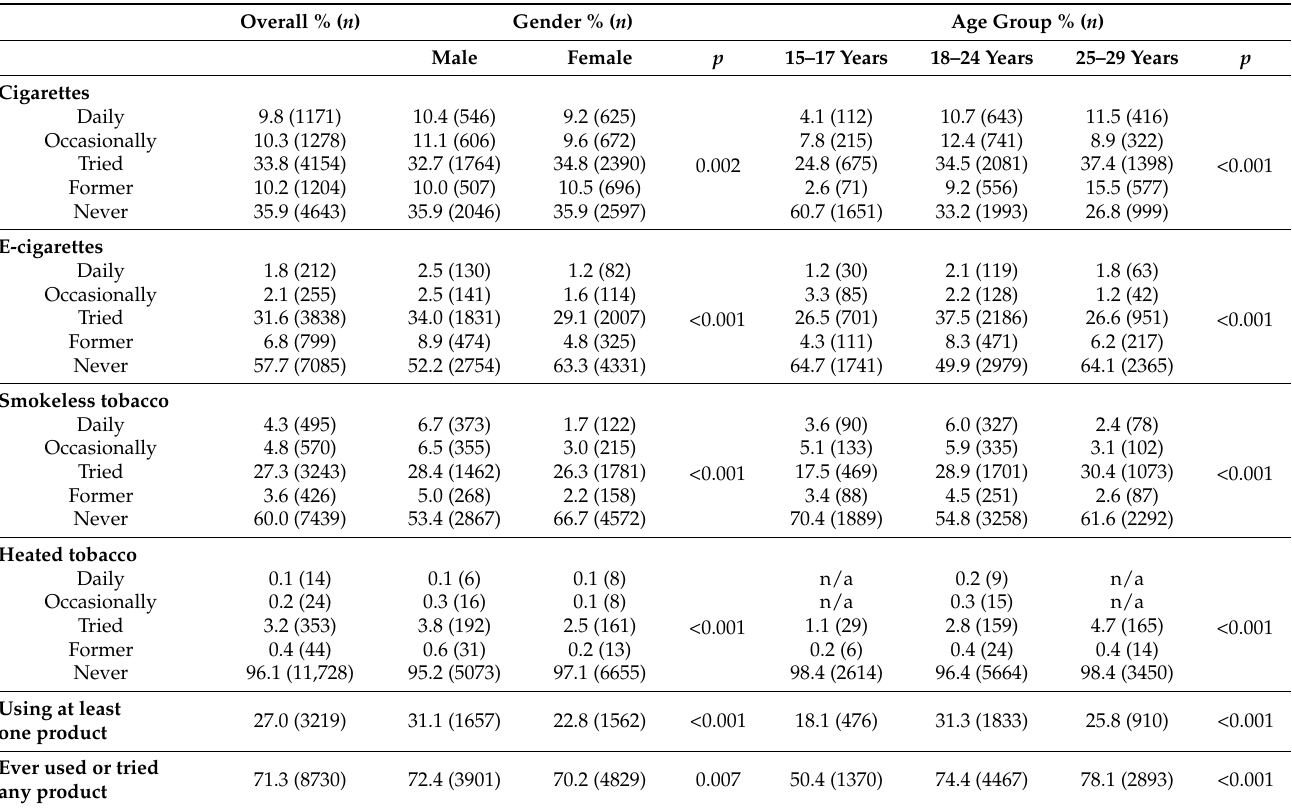
Table 3. Use of tobacco or nicotine products by gender and age group, p -value for differences by gender and age